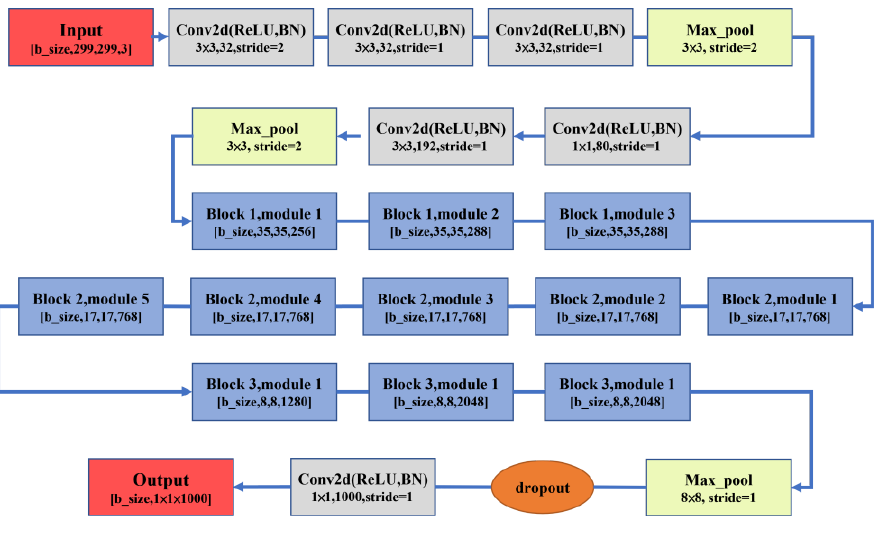
Figure 7. InceptionV3 architecture.